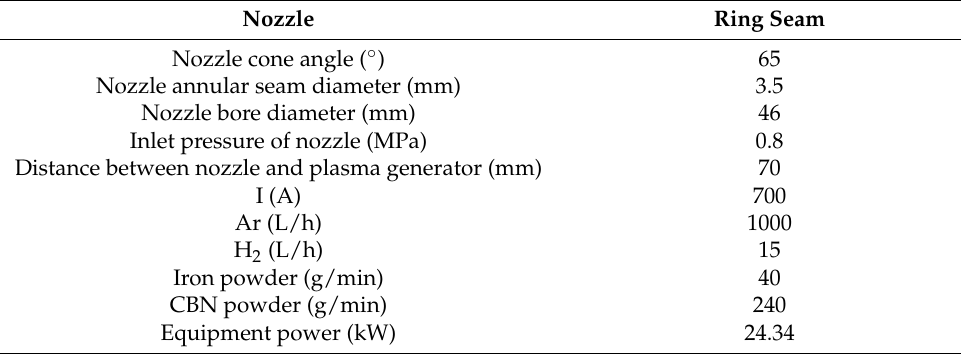
Table 1. Operating conditions of